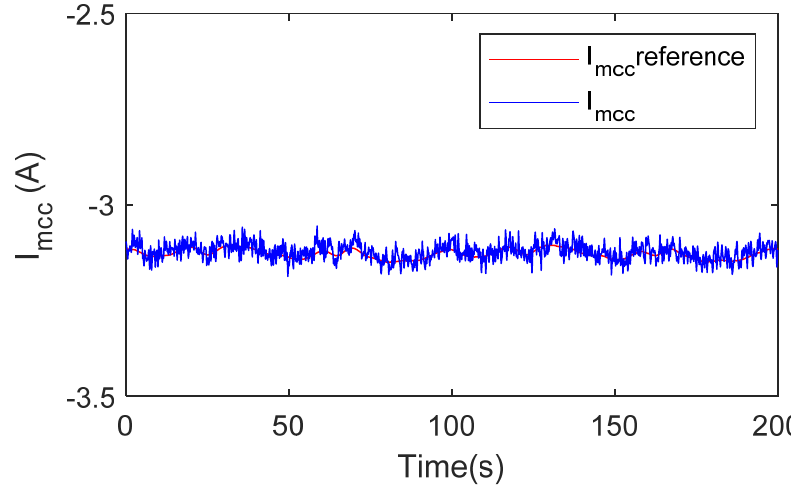
Figure 16. DC motor current control result used to emulate the wind turbine.